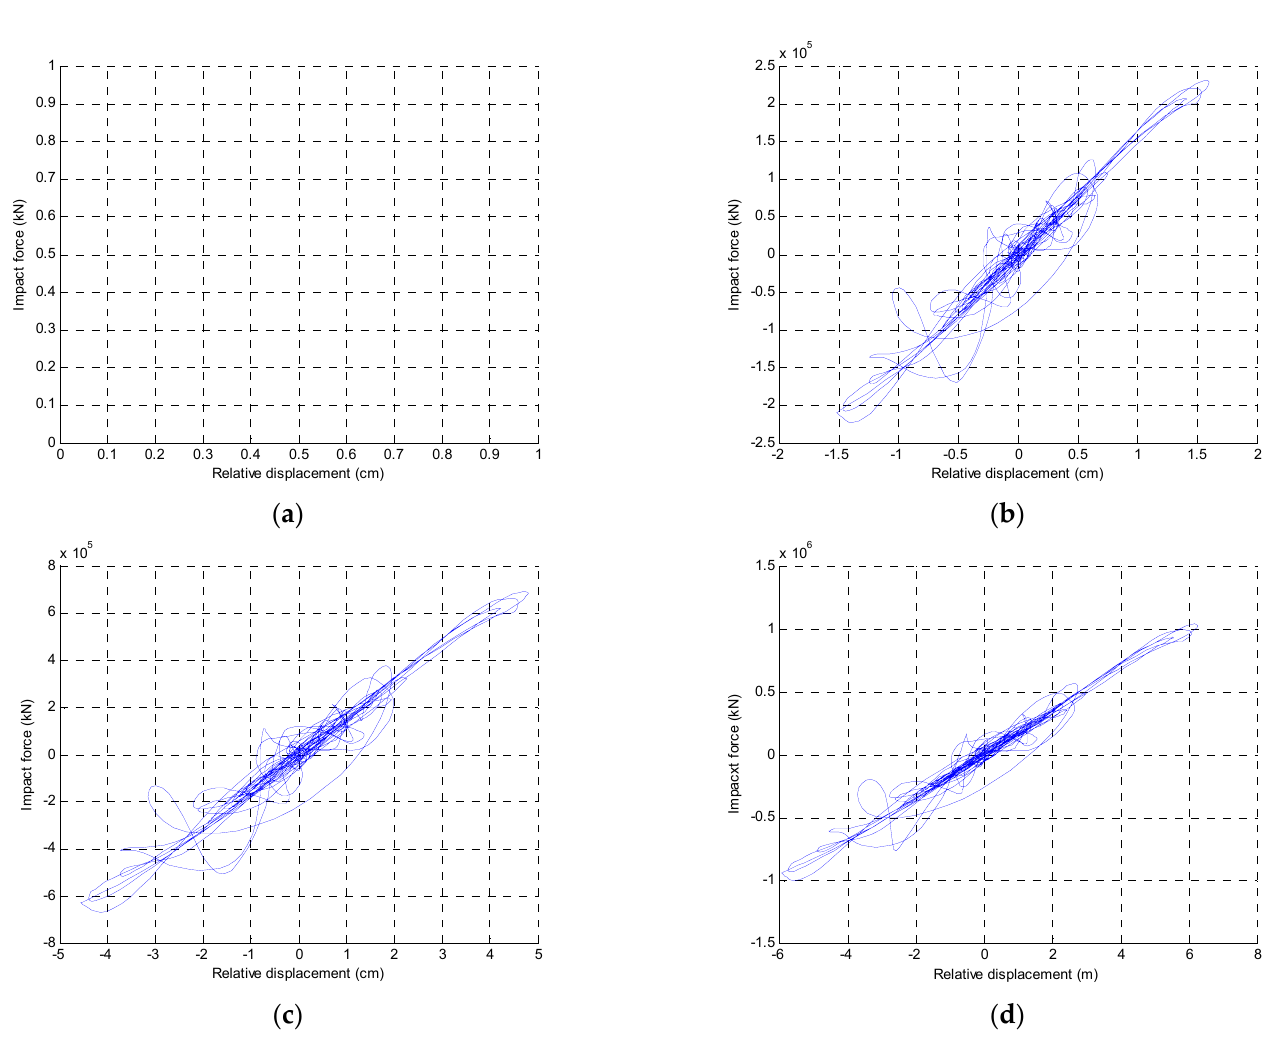
Figure 7. Lateral displacement time histories of non ‐ isolated and the isolated buildings with an 8 cm size gap: ( a ) base level; ( b ) first story; ( c ) second story; ( d ) third story. The maximum impact forces in each story were calculated to be 2.38 × 10 5 kN, 6.9 × 10 5 kN and 10.05 × 10 5 kN for the first, second and the third story, respectively (see Figure 8). Moreover, time histories for the impact forces are presented in Figure 9.